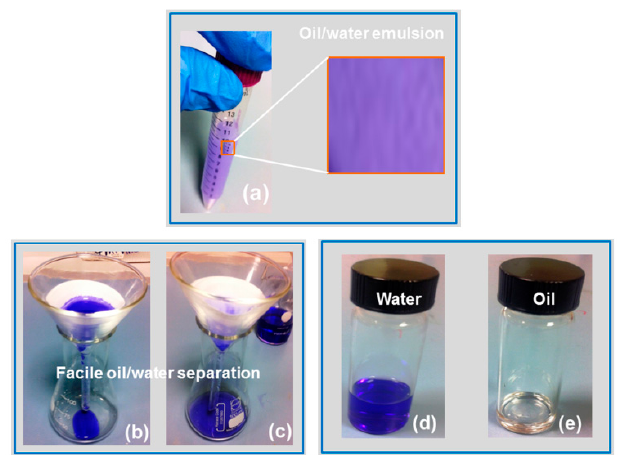
Figure 7. Different steps of oil–water separation experiments on 10 mL of oil-in-water non-stabilized emulsion. ( a ) Oil/water emulsion. Inset shows zoomed view for oil/water emulsion. Here, water is colored with methylene blue dye, in order to be distinguished from oil; ( b , c ) Separated water finishes at the bottom of the flask and separated oil remains on the filter paper; ( d , e ) Water and oil stored separately after filtration.